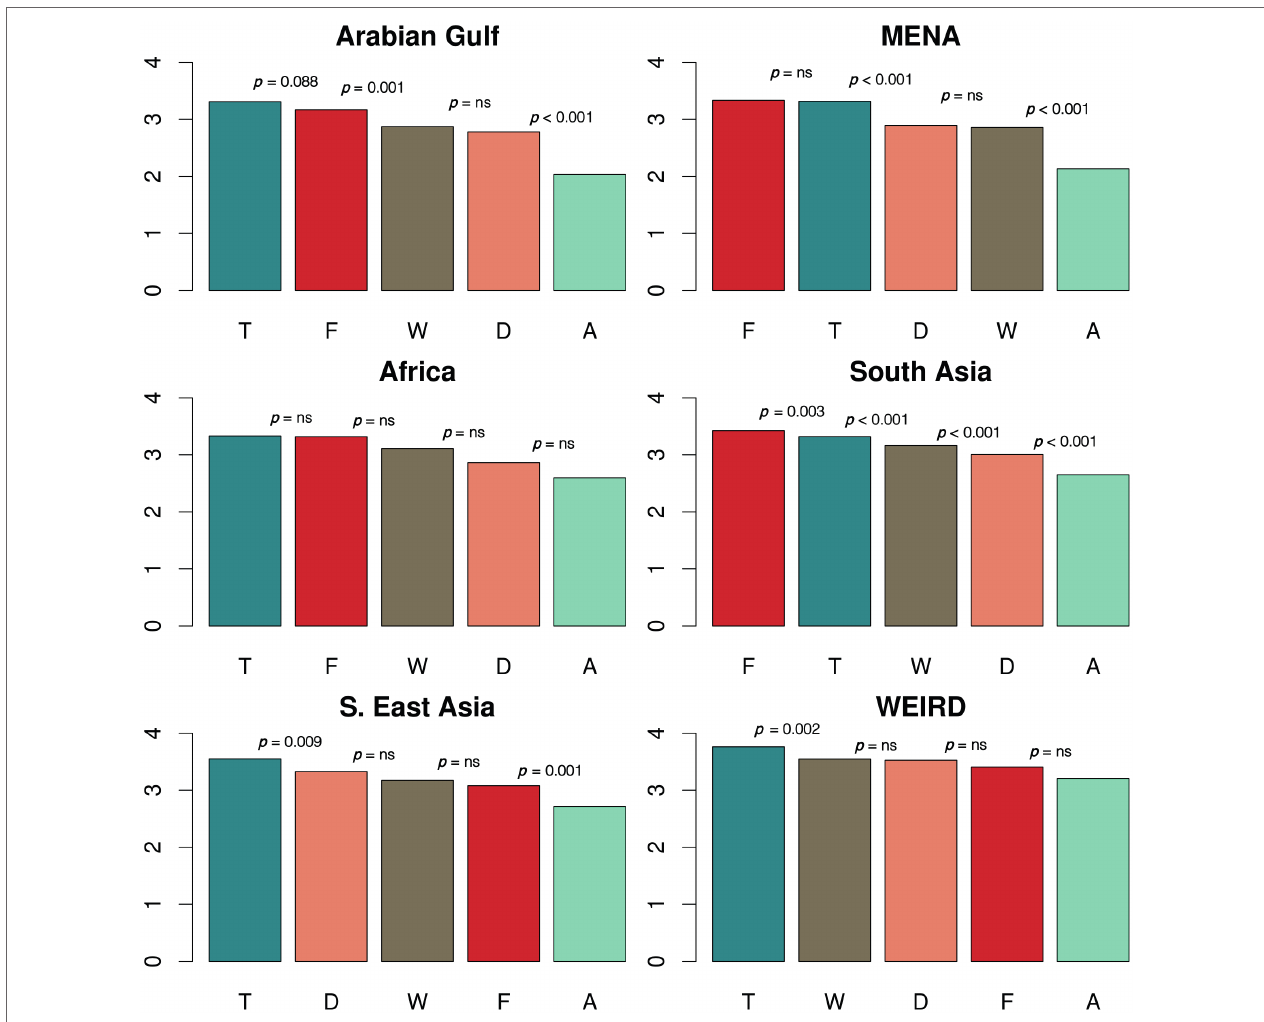
FIGURE 1 | Ranking of Animal Preferences by Culture. D = Dugong. W=Whale shark. T = H.S. Turtle. F = S. Falcon, A = S.T. Agama. p : p -values from paired t -tests. ns: not significant at